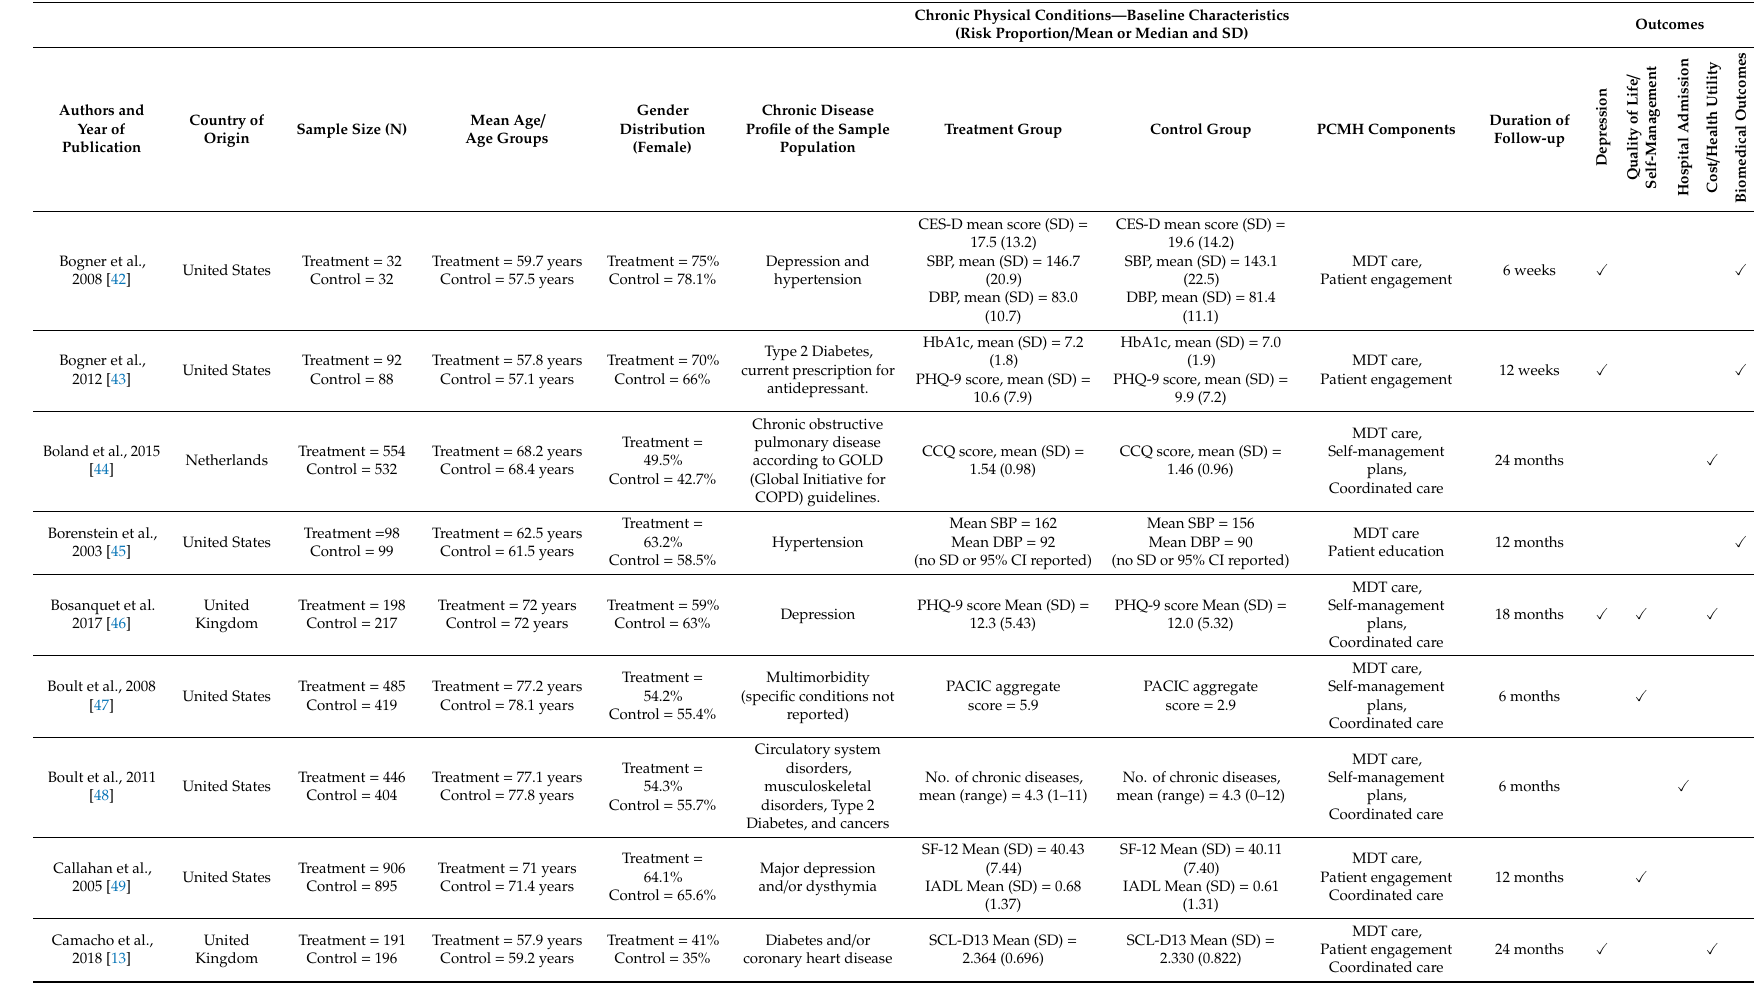
Table A3. Cont. Chronic Physical Conditions—Baseline Characteristics (Risk Proportion / Mean or Median and SD)